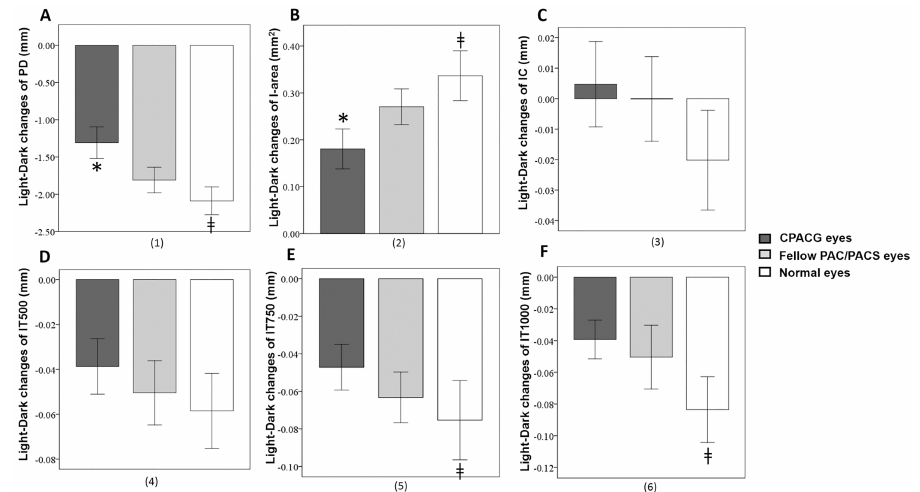
Fig 5. Light-to-dark changes of iris parameters in CPACG eyes, fellow PAC/PACS eyes, and normal eyes. A: The light-to-dark changesof PDs were largest in normal eyes and least in CPACG eyes. B: The light- to-dark changesof I-areas were largest in normal eyes and least in CPACG eyes. C: There was no significant difference in iris curvature changesin responseto light amongnormal eyes, PACS/PAC eyes, and CPACG eyes. D: There was no significantdifference in the light-to-dark changesof IT500 μ mamongnormal eyes, PACS/PAC eyes, and CPACG eyes. E: The light-to-dark changesof IT750 μ mwere smaller in CPACG eyes than in normaleyes. There was no significantdifference betweenPACS/PAC eyes and CPACG eyes in the iris thickness. F: The light-to-dark changesof IT1000 μ mwere smaller in CPACG eyes than in normal eyes. There was no significantdifference betweenPACS/PAC eyes and CPACG eyes in the iris thickness. CPACG: chronicprimary angle closureglaucoma;PAC: primary angle closure; PACS: primary angle closuresuspect; PD: pupil diameter; I-area: iris area; IC: iris curvature; IT500 μ m/IT750 μ m/IT1000 μ m:iris thicknesses 500 μ m/ 750 μ m/1000 μ m from the iris root. * : significantdifference betweenPACG eyes and fellow eyes ( P < 0.017); †: significantdifference betweenfellow PAC/PACS eyes and normaleyes ( P < 0.017); ‡: significantdifference betweenPACG eyes and normaleyes ( P < 0.017); Error bars: 95% confidenceinterval (95% CI).